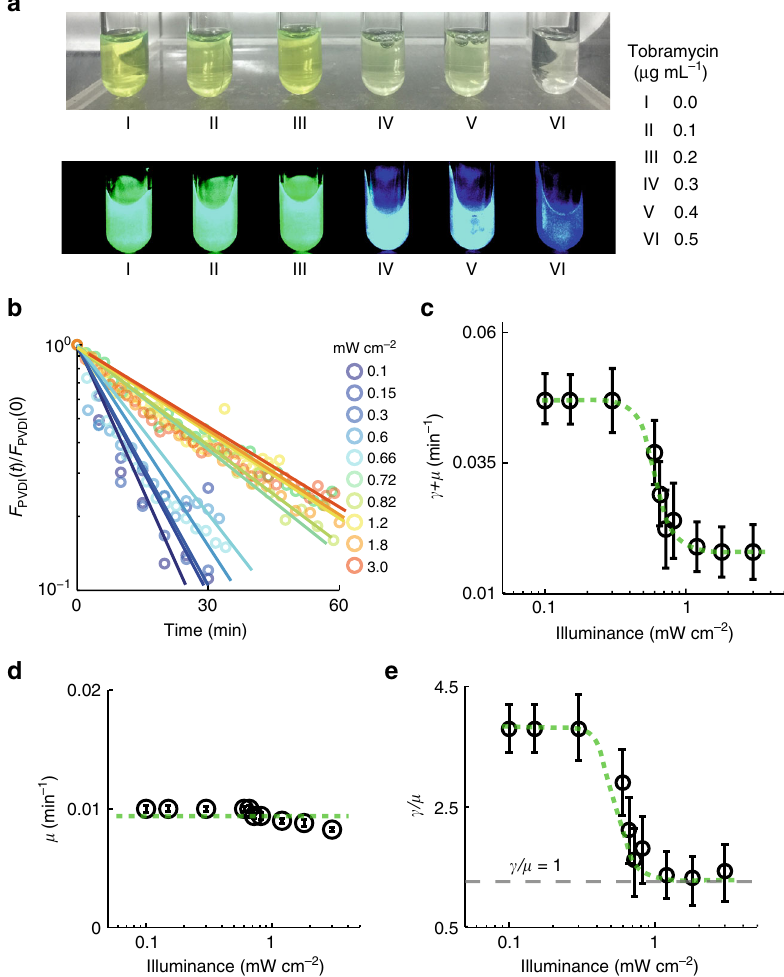
Fig. 3 P. aeruginosa tunes down the ef fl ux of PVDI in the presence of environmental stresses. a Representative regular + fl uorescent photos show that the amount of PVDI in the supernatant of bacterial cultures negatively relates to the concentration of tobramycin, where all the bacterial cultures were harvested at an identical bacterial density (O.D. 600 = 0.3). b Decline of PVDI fl uorescence intensity in the presence of different photon-stresses indicates that bacteria tune down the ef fl ux of PVDI, where dots and lines represent the average intensities and the fi tting lines using exponential fi tting, respectively, with the magnitude of the photon-stress of 0.1, 0.15, 0.3, 0.6, 0.66, 0.72, 0.82, 1.2, 1.8, and 3.0 mWcm (cid:1) 2 , from bottom to top. c-e Photon-stress dependence of c γ þ μ ð Þ , d μ , and e γ = μ , where γ or μ represents the PVDI ef fl ux rate or bacterial growth rate, respectively. The error bars in c – d are the standard deviation of experimental